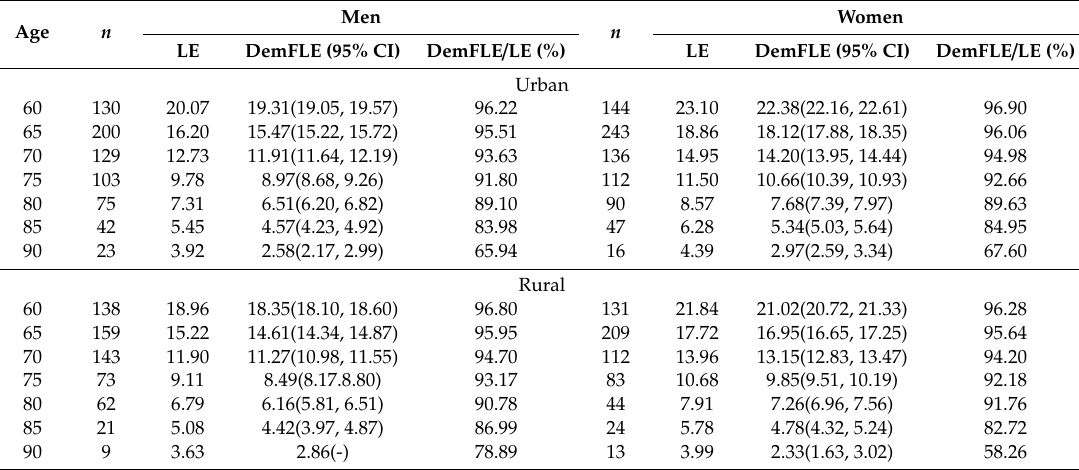
Table 2. LE, DemFLE, and the proportion of DemFLE for selected ages in urban and rural